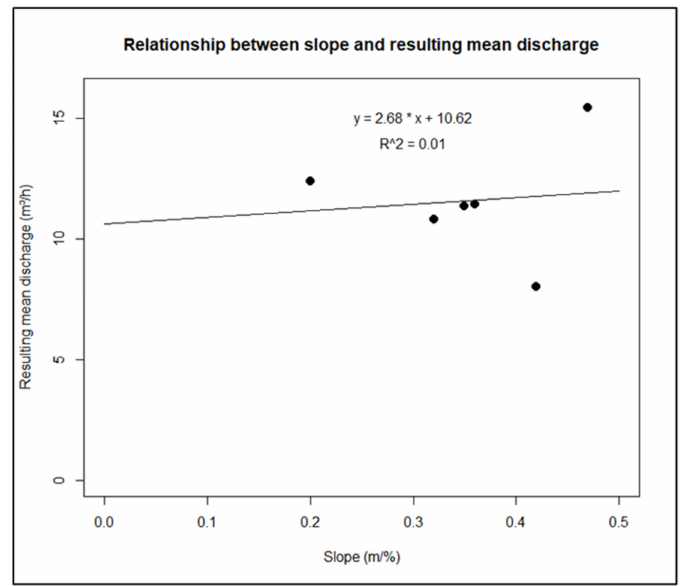
Figure 13. Relationship between the slope (X, m/%) and the resulting average discharge (Y, m 3 /h) for all lithological